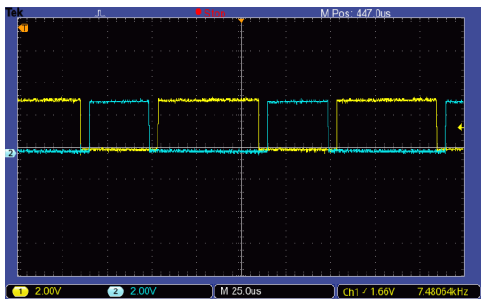
Figure 23. PWM (Pulse Width Modulation) control waveform of phase A.